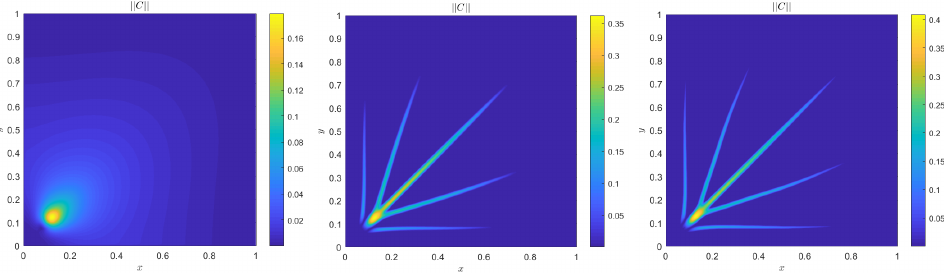
Figure 4. In this figure, we show the results for variable C varying the parameter ε . On the left, we have the results of T EST I ( ε = 10 − 2 ), in the central panel, T EST D ( ε = 10 − 3 ) , and on the right, T EST L ( ε = 10 − 4 )